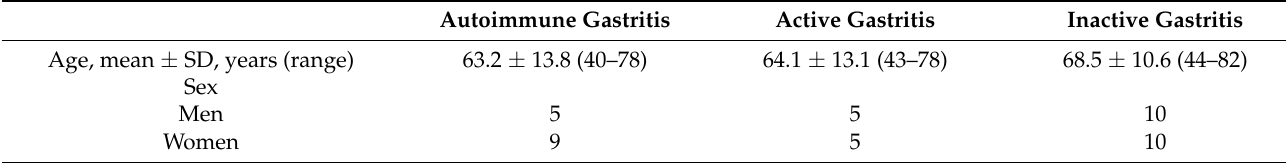
Table 1. Patient characteristics of autoimmune, active, and inactive gastritis.